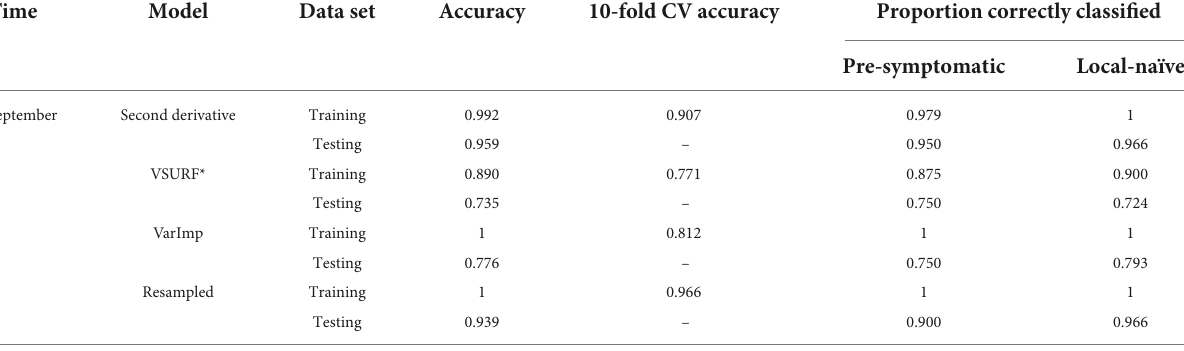
TABLE 5 Accuracies of the four distinct support vector machine (SVM) models used to classify leaf near-infrared (NIR) spectra based on tree symptom type for the September dataset. Time Model Data set Accuracy 10-fold CV accuracy Proportion correctly classified